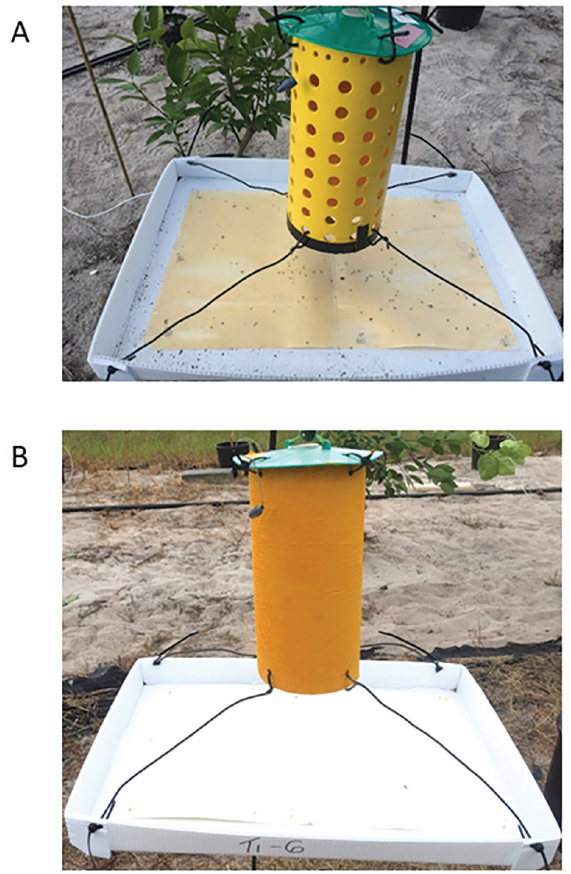
Figure 1. Image of attract-and-kill (AK) device prototypes in the field with horizontal sticky trays to capture dead and moribund Diaphorina citri. ( A ) Perforated cylinder AK device with spreadable emulsified wax dyed with yellow color (SPLAT) card inside. SPLAT with all the ingredients was applied to the corrugated plastic card (SPLAT card) inserted inside the cylinder ( B ) Solid cylinder AK device. SPLAT containing all ingredients was applied to the aluminum foil on outer surface of the yellow cylinder. Attractant was released from rubber septa attached to the top of cylinders.